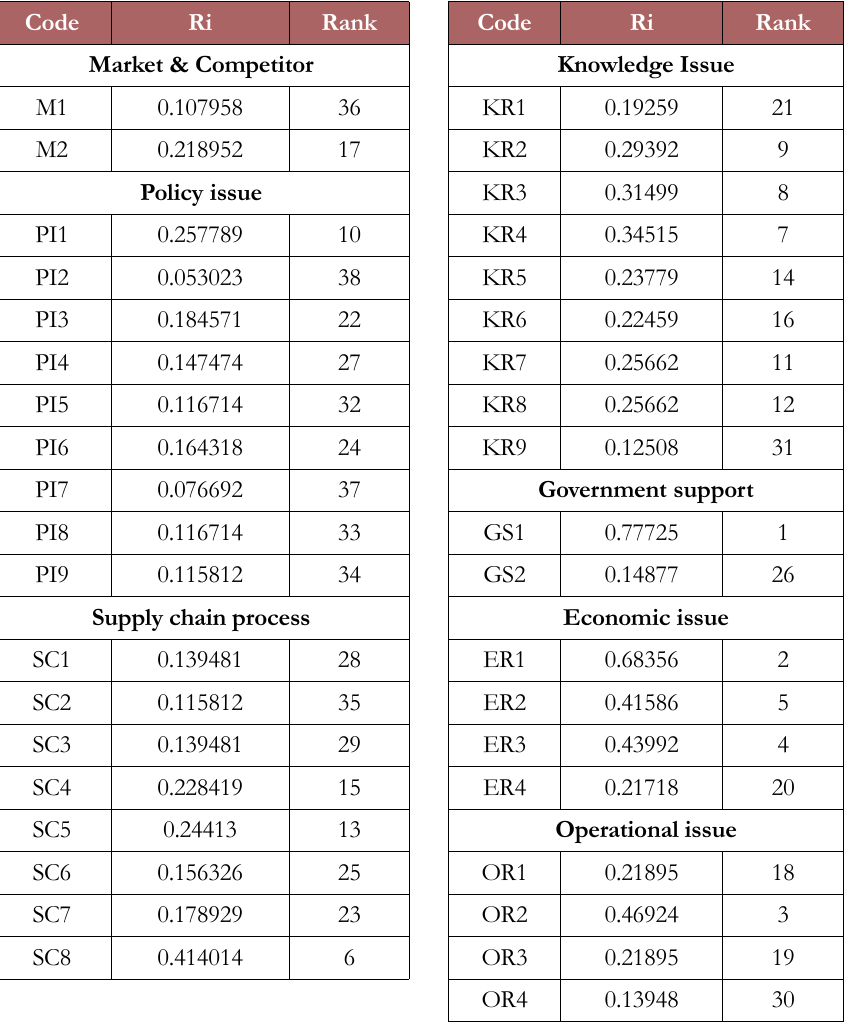
Table 3. Barrier rank, the result from TOPSIS